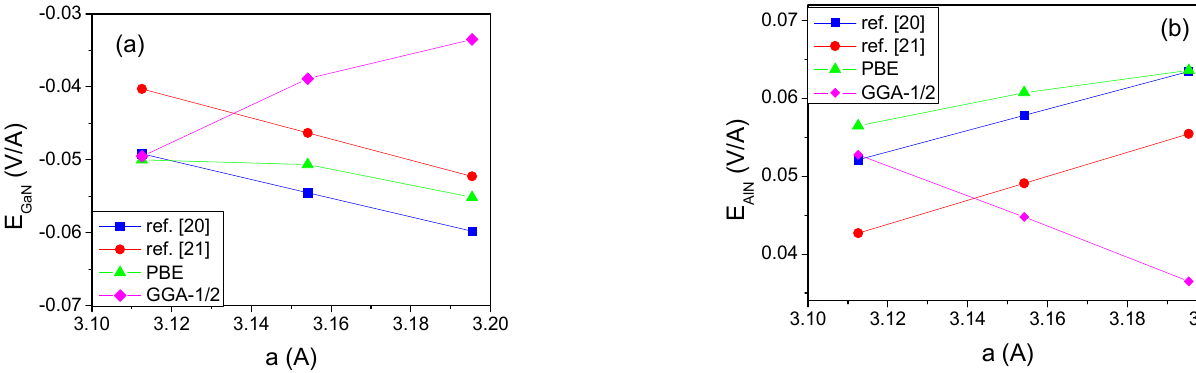
Figure 5. Electric fields in the well ( a ) and barrier ( b ) in 8AlN-8GaN atomic layers superlattice for various values of a lattice parameter a . The data denoted as refs. [20,21] were calculated using the values listed in Table 1 via Equation (3); the data denoted PBE and GGA-1/2 were obtained from ab initio electric potential using these two approximations. A similar approach was used for the determination of GaN-InN polarization